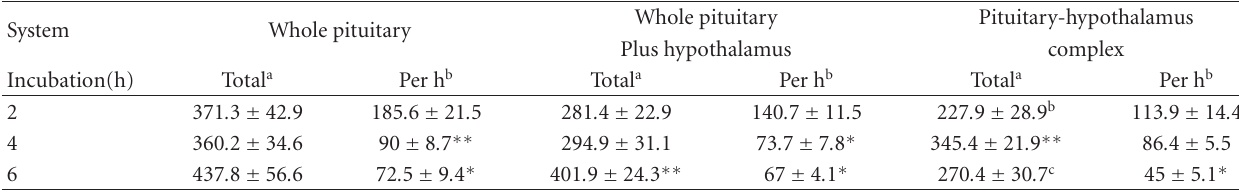
Table 1: Release of Prolactin by di ff erent pituitary constructs in